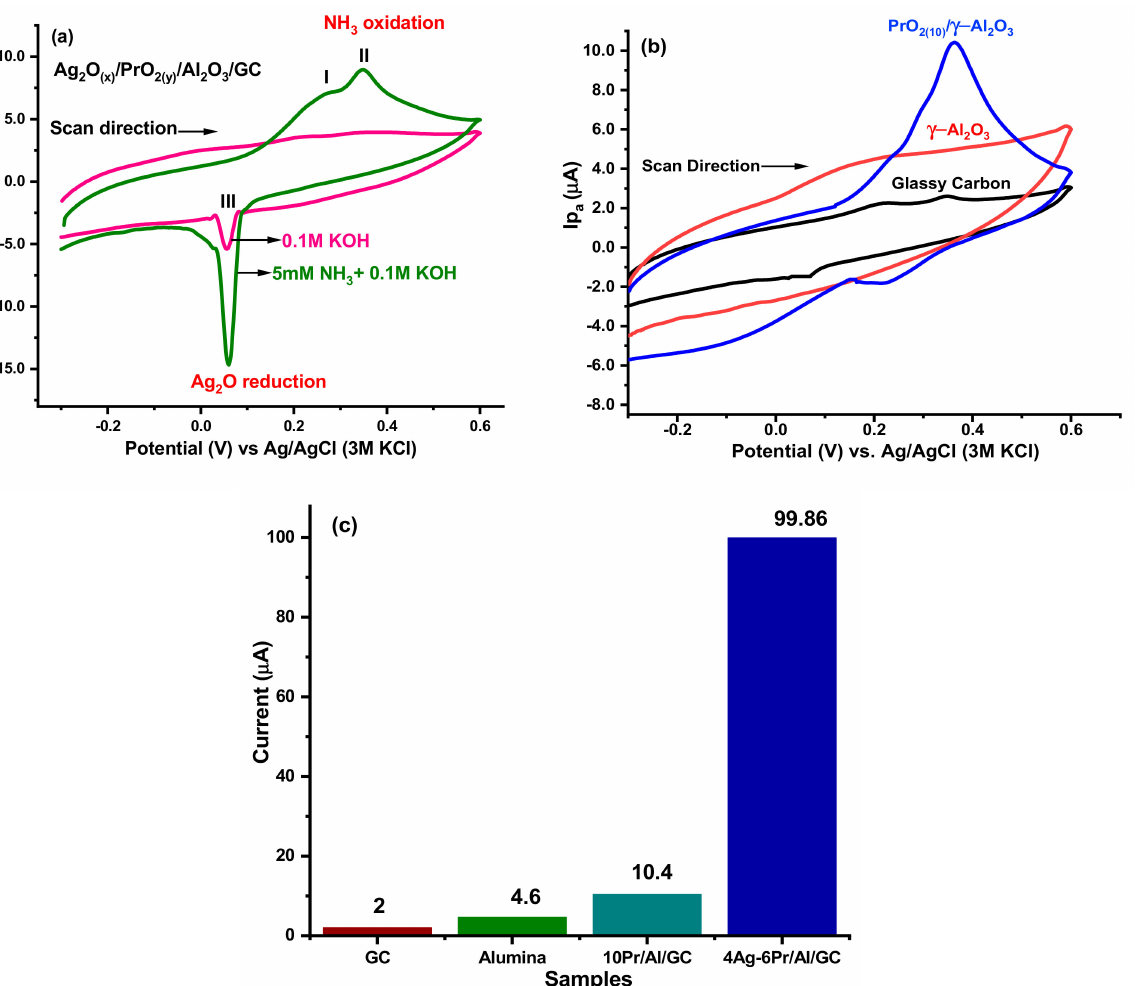
Figure 7. ( a ) Electrochemical responses and peak position in 0.1 M KOH and 5 mM NH 3 . ( b ) Cyclic voltammograms towards ammonia oxidation over the surface of bare glassy carbon, γ -Al 2 O 3 and PrO 2(10) / γ -Al 2 O 3 modified electrodes 0.1 M KOH and 5 mM NH 3 . ( c ) Comparative peak current response for bare GC, γ -Al 2 O 3 , and lowest and optimal composition,